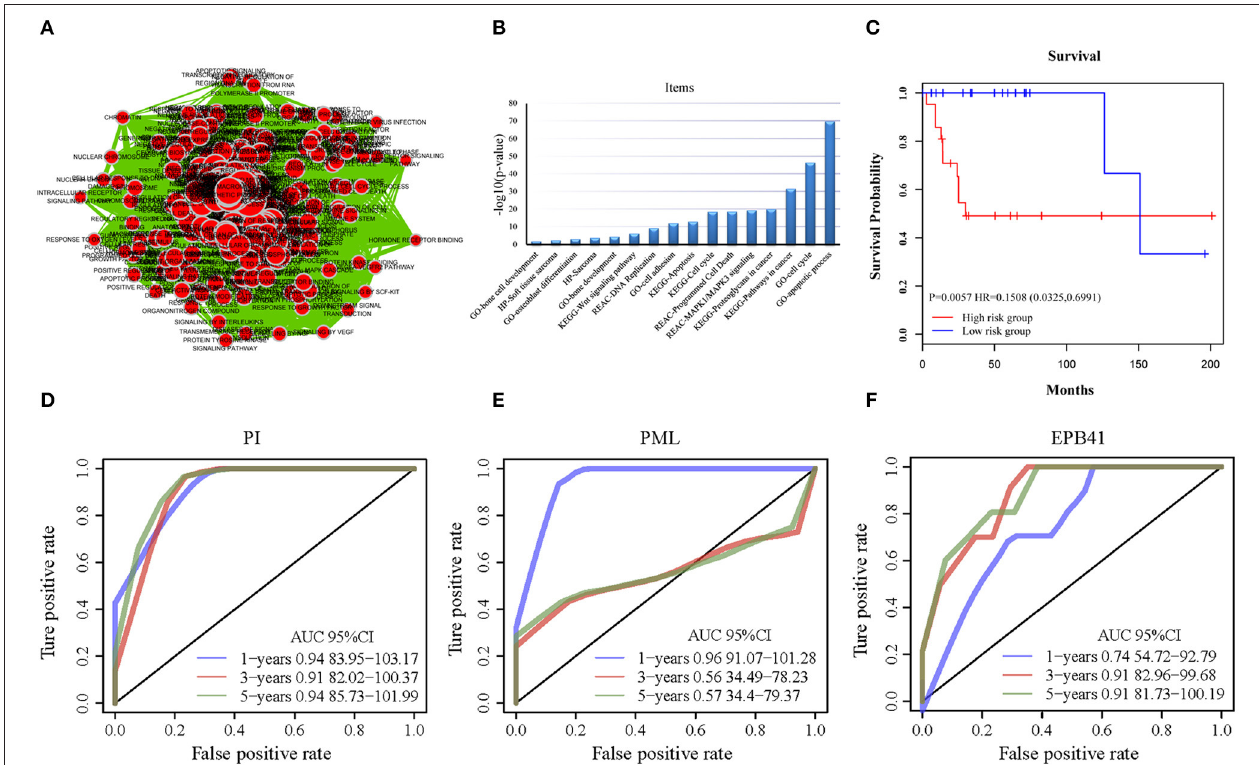
FIGURE 4 | The functional analysis of candidate genes. (A) Visualization for functional enrichment results of 733 candidate genes by Cytoscape software. Each node represents an annotation term. (B) The results of g: profiler functional enrichment with prognostic candidate genes. Horizontal axis above represents annotation terms. Vertical axis represents the value of –log 10 ( p -value). (C) The Kaplan–Meier curves for overall survival of high- and low-risk groups of OSA in the internal training dataset and external validating dataset. The prognostic differences between the two groups in internal training dataset was significant (log-rank test p = 0.0057). (D) ROC of PML-EPB41 signature based on PI in training dataset samples. (E) ROC of PML signature in training dataset samples. (F) ROC of EPB41 signature in training dataset samples.